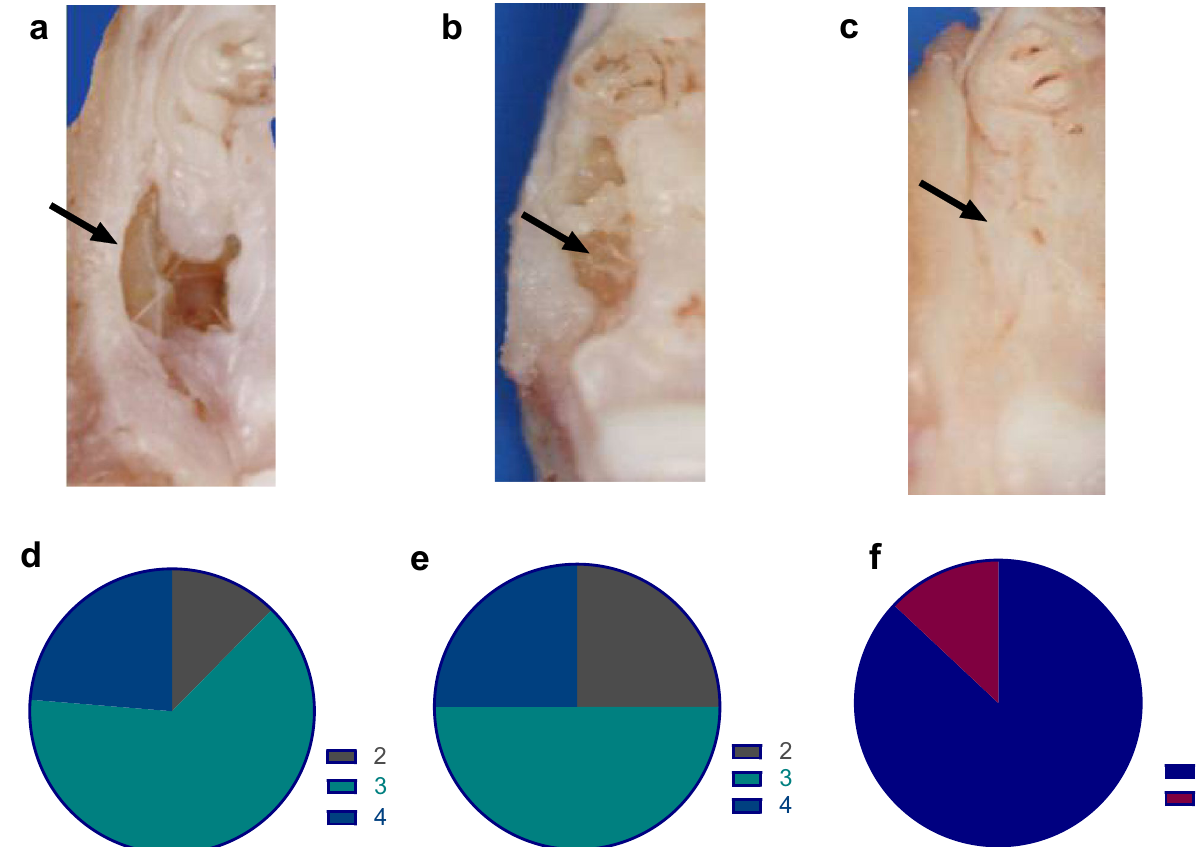
Figure 2. Clinical images of MRONJ lesion/defect area (black arrows) in no-gel ( a ), gel-alone ( b ) and VEGF- gel groups ( c ); Pie-charts demonstrating the distribution of MRONJ classification stages in the three treatment groups; no-gel ( d ), gel-alone ( e ) and VEGF-gel group ( f and 67.87 ± 9.12 ng from the 100 ng loaded gel by the end of 28 days, demonstrating that only partial release of the growth factor was achieved during the experimental period. As the 200 ng dose could rapidly deliver 20 to 30 ng of VEGF within twelve hours and sustained release thereafter, it was deemed to have the greater potential for inducing in vivo neovascularization. Hence, the 200 ng dose was utilised in the rest of the study. Gross morphological examination. The maxillae were dissected carefully without disturbing the over- lying mucosa. Gross osteonecrosis, in the form of incomplete wound closure, inflammation and presence of necrotic bone (sequestra) was evident in the maxillary defects with no-gel group, and to a lesser extent, in the gel-alone group, after 4 weeks healing of the extraction defect site (Fig. 2a–c). However, complete wound closure was noted in the rats treated with VEGF hydrogel. MRONJ grading in the no gel group revealed that 62% of the rats were classified as grade 3 and 23% as grade 4 with the remainder being grade 2. In the gel-alone group, 50% were classified as grade 3 MRONJ and the rest were equally split between grade 2 and grade 4. However, the VEGF-gel group demonstrated drastically improved healing, with the majority of animals recording grade 0 (87%) with the rest (13%) being rated grade 1 (Fig. 2d–f). Histological findings. Quantification of osteonecrosis. Quantification of osteonecrosis in the defect site showed significantly higher areas of necrotic bone (empty lacunae) in the untreated (no-gel) animals at the end of 4 weeks healing (Fig. 3a,b). These untreated animals showed a significantly higher necrotic area compared to the VEGF treated group (4.78 ± 0.35 × 10 5 µm 2 vs 1.42 ± 0.14 × 10 5 µm 2 , p < 0.0001; Fig. 3b). Further, the gel-alone group also had significantly lower areas of necrotic bone compared to the untreated group (2.64 ± 0.17 × 10 5 µm 2 , p = 0.0001) but significantly higher osteonecrosis than the VEGF treated group (p = 0.009). These results suggest a positive role for VEGF in the prevention of ZA induced MRONJ (Fig. 3b). Quantification of inflammatory infiltrate. Significantly larger areas of inflammatory reaction were noted within the extraction sockets and around the sequestrum in the untreated group, in comparison to the VEGF treated group (7.01 ± 0.93 × 10 4 µm 2 vs 1.29 ± 0.18 × 10 4 µm 2 , p < 0.0001). The gel-alone group showed marginally higher volume of infiltrate (2.92 ± 0.24 × 10 4 µm 2 ) than the VEGF group (p = 0.142) suggesting that VEGF had minimal role in reducing the inflammatory component. However, the inflammatory infiltrate in the no-gel and gel-alone